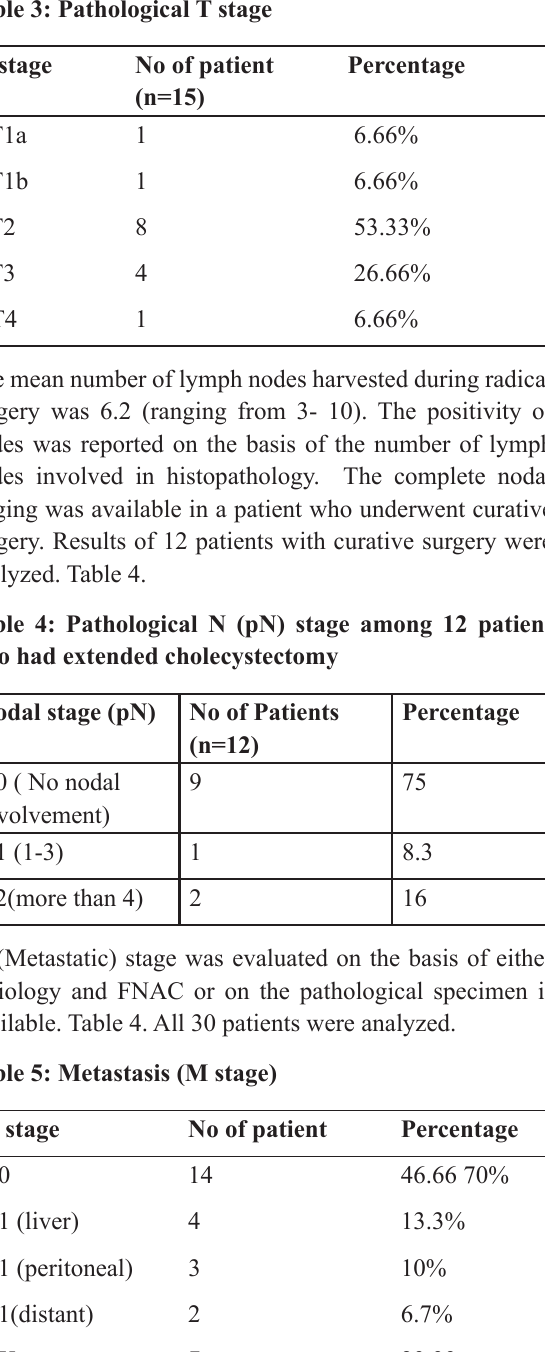
Table 3: Pathological T stage